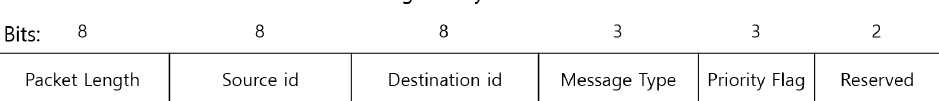
Figure 11. MAC frame format.